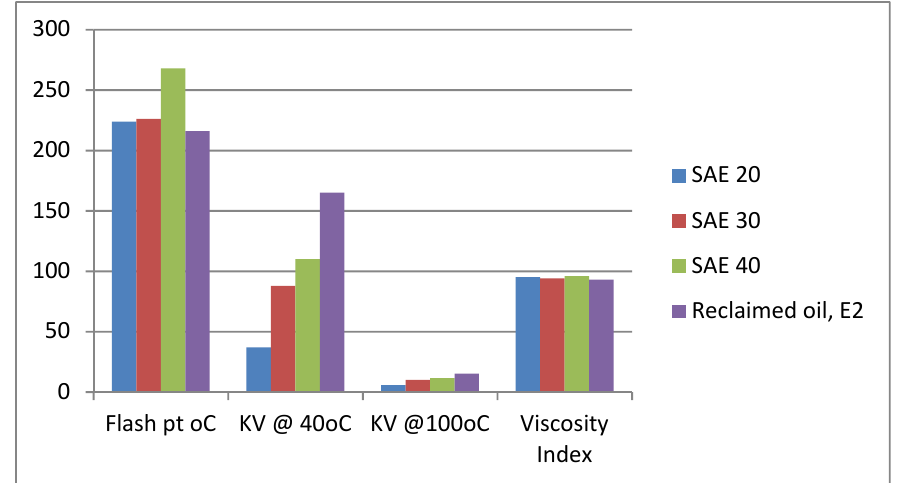
Figure 4. Comparison between SAE20, SAE 30, SAE 40 and reclaimed oil (E2).